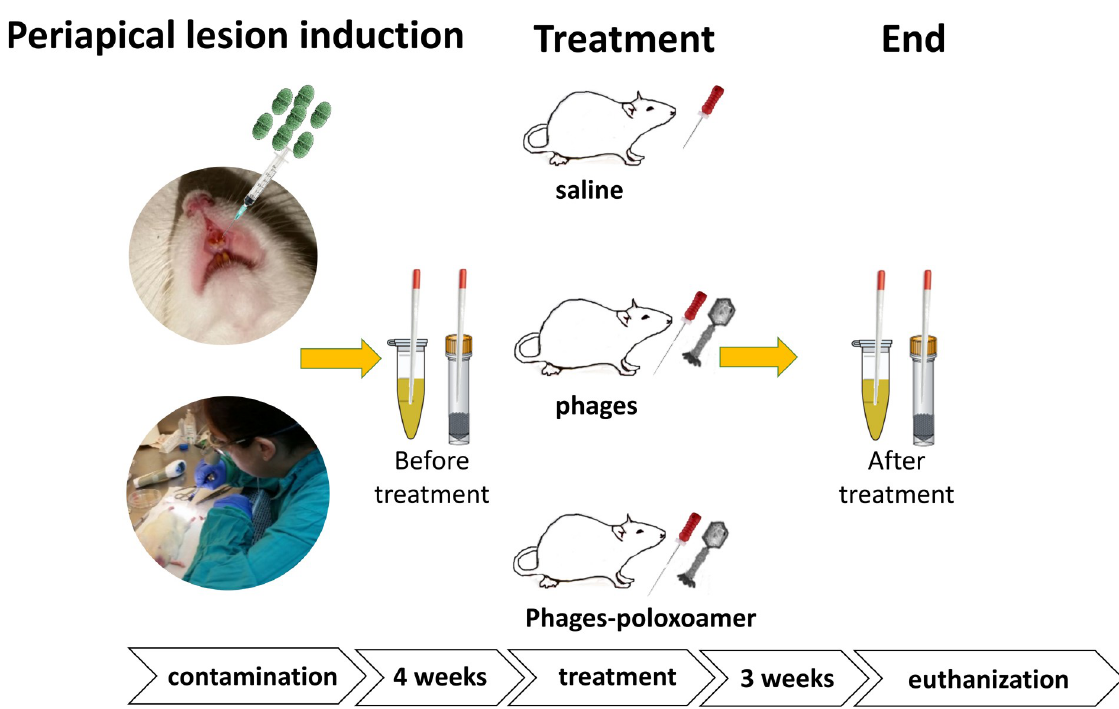
Fig 1. Periapical lesions were induced in a rat model. Dental pulp of the maxillary incisor teeth of male Wistar rats were exposed and infected with E . faecalis (VRE ATCC 700802). Standard root canal treatment was conducted using instrumentation and one of the following treatments: group A: saline irrigation; group B: EFDG1/EFLK1 phage cocktail irrigation (10 9 PFU/mL); group C: EFDG1/EFLK1 poloxamer- phage formulation (10 9